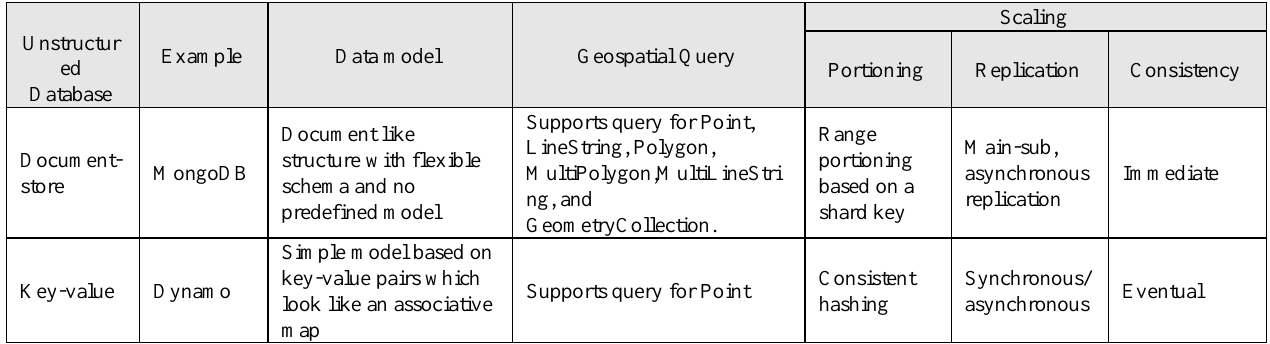
Table 1: Overview of Unstructured